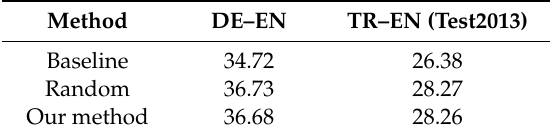
Table 6. Comparison of our work with di ff erent random seeds.